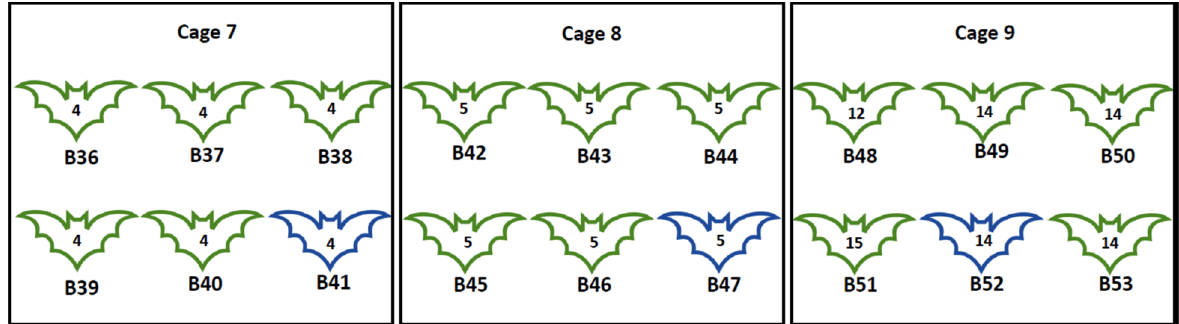
Figure 7. Experiment II. Number, sex of bats, and the number of bat MARV ‐ inoculated flies released on seronegative Egyptian rousette bats. B = Bat identification number 36–53; Green outline = Female; Blue outline = Male; number on the bat = Number of MARV ‐ inoculated flies released on each bat.